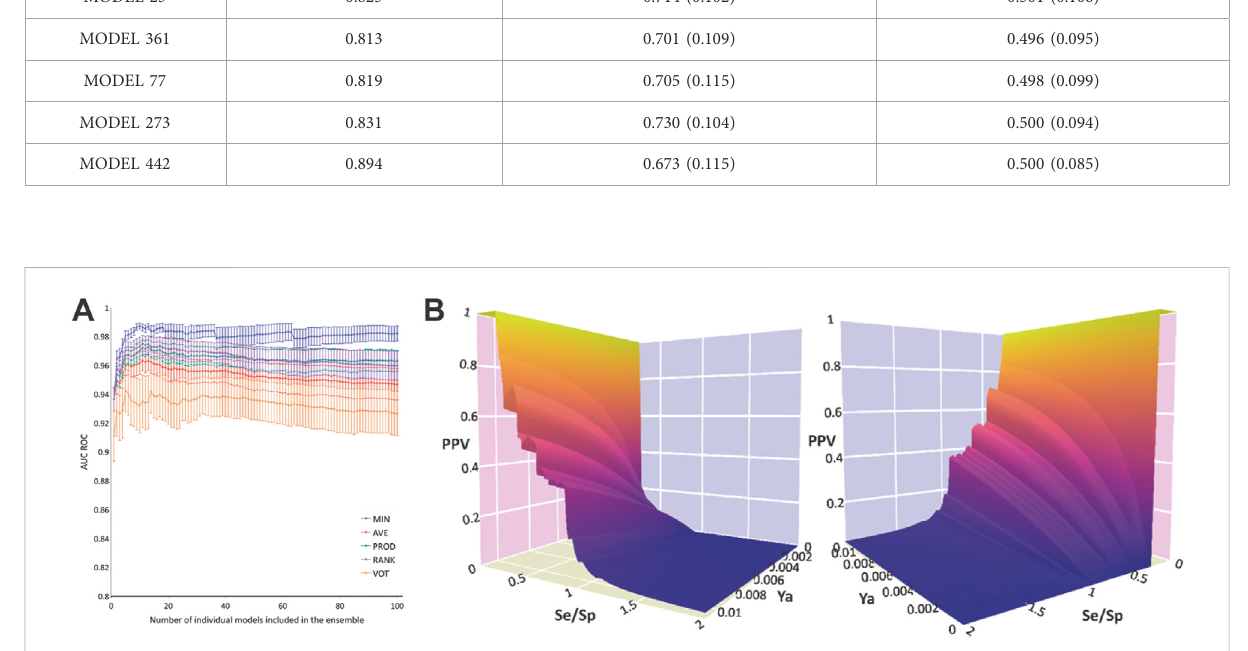
FIGURE 1 Data plots from retrospective and prospective in silico screening against MPro. (A) AUC ROC obtained in the retrospective screening as a function of the number of combined models for each operator. (B) Two different views of the PPV surface of the MIN-22 ensemble. Se/Sp refers to the Sensitivity/Speci fi city